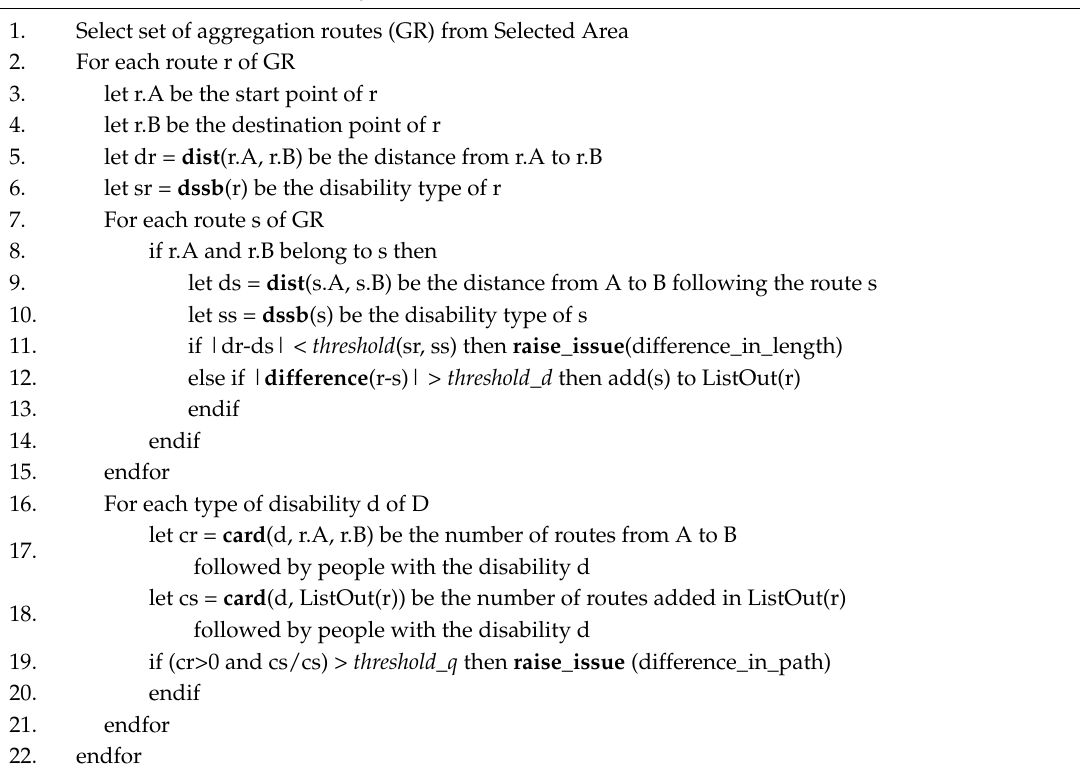
Algorithm 1. Detection Accessibility